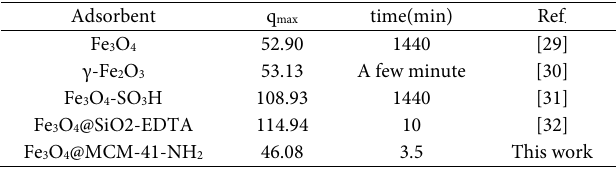
Table 7 Comparasion for the removal of lead by different adsorbent. Table 7. Comparasion for the removal of lead by different adsorbent Adsorbent q max time(min) Ref . Fe 3 O